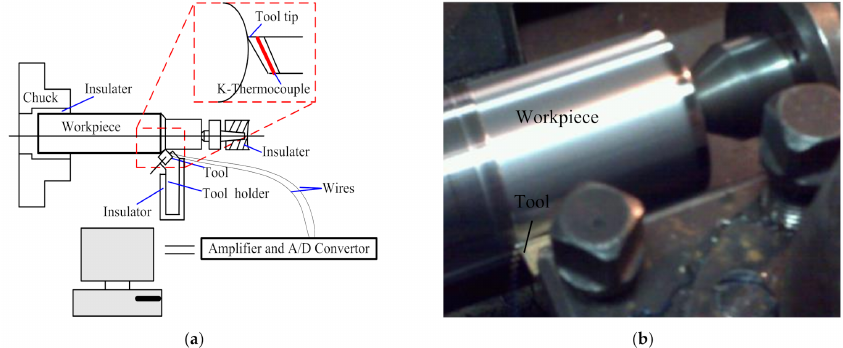
Figure 3. Tool temperature measurement set-up ( a ) schematic and ( b ) actual photograph. The tool is a mono layer coated tool, namely, KC735M cutting tool (Kennametal Inc.,